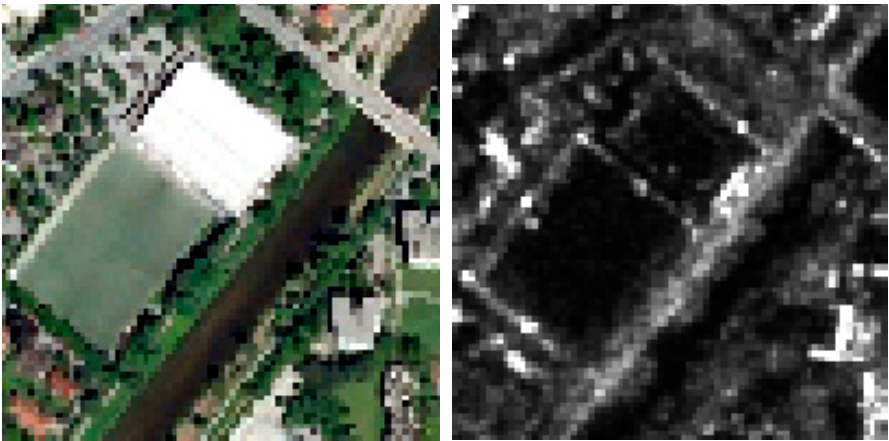
Figure 2. Examples of nonlinear intensity differences between multimodal images. ( Left ) Visible and ( Right ) synthetic aperture radar (SAR) images.